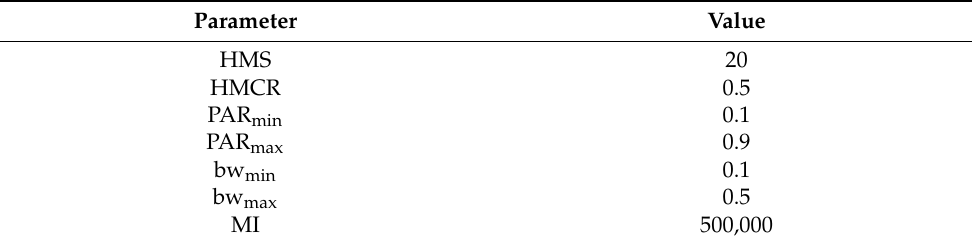
Table 1. Values for multiobjective harmony search parameters.